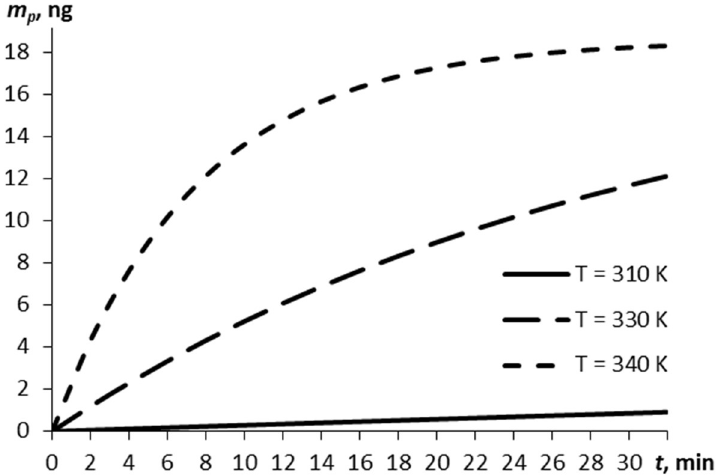
Figure 1. The vapor mass over time for different temperatures of the RDX film. The higher the film temperature, the greater the vapor mass (0.86 ng at 310 K and 18.23 ng at 340 K at 30 min).